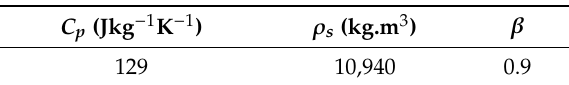
Figure 15. Temperature variation in the specimen during the test at constant temperature. Table 11. Material properties.